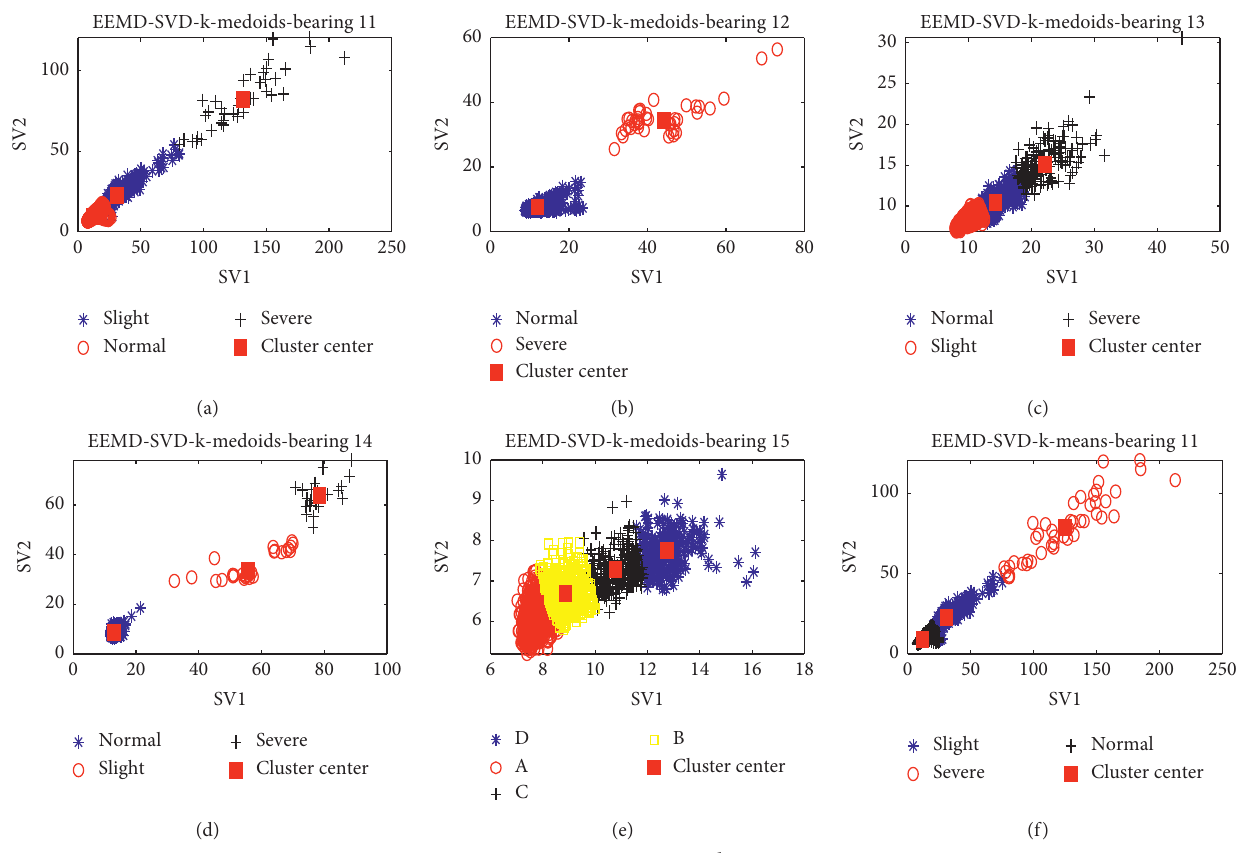
EEMD-SVD-k-medoids-bearing